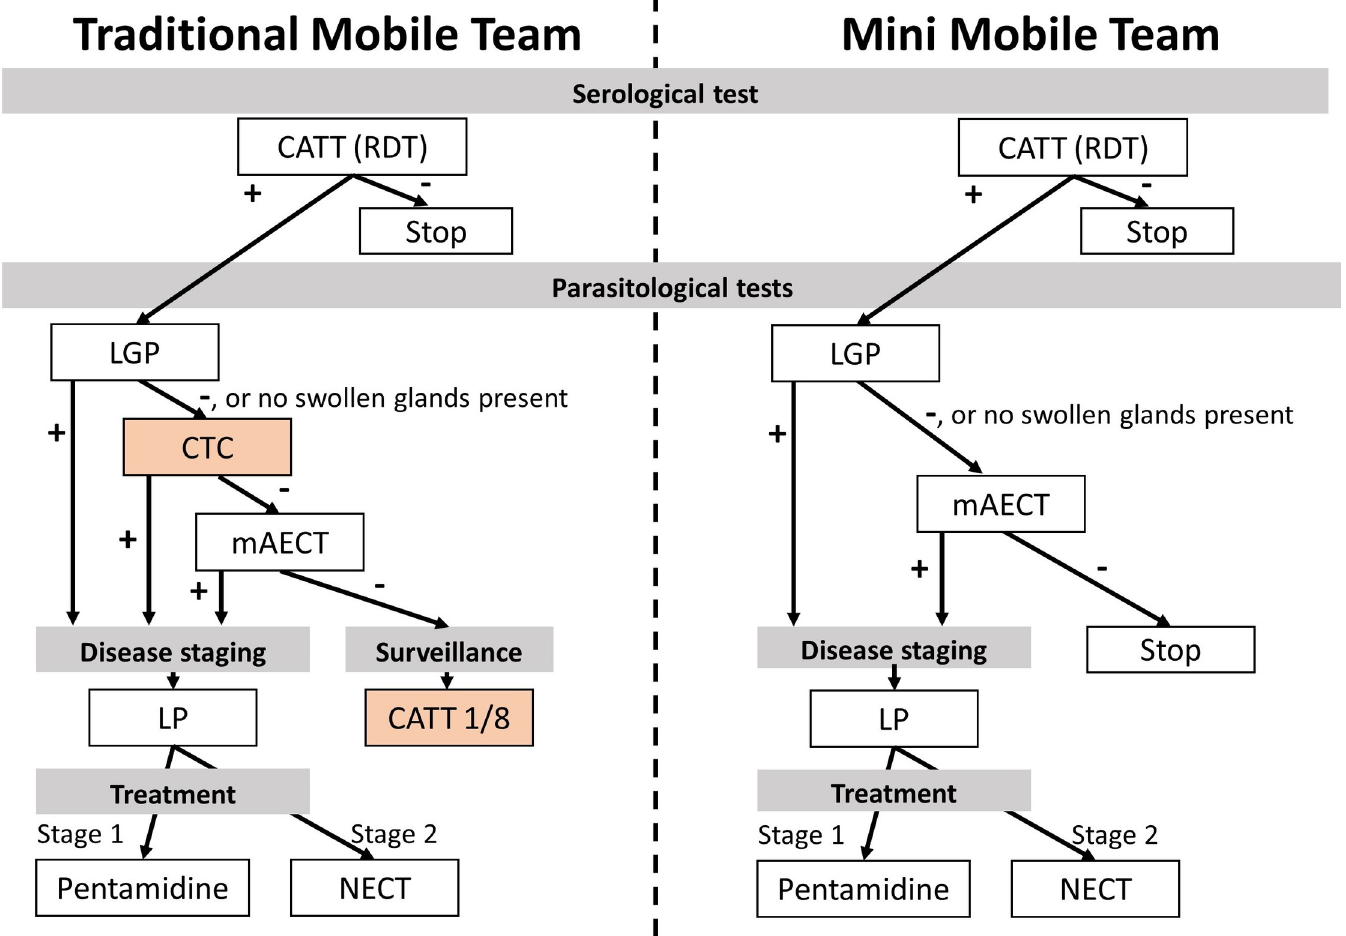
Fig 2. Differences in diagnostic